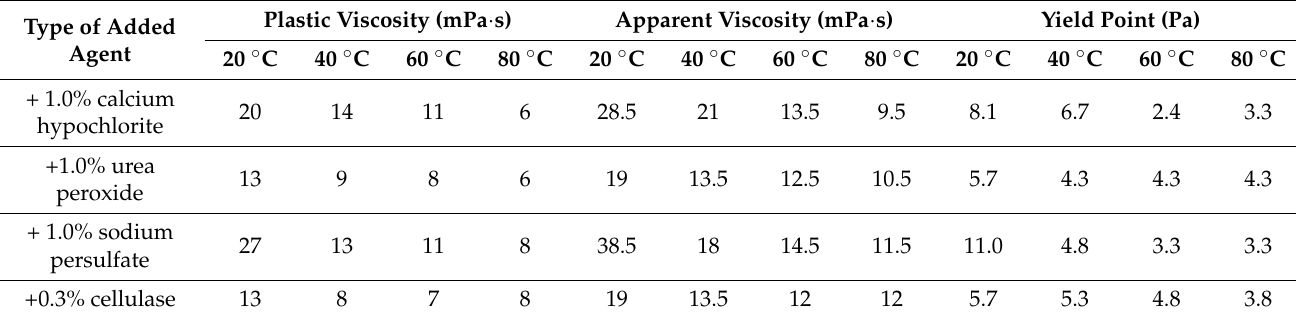
Table 4. The rheological parameters of potassium-polymer drilling mud B with thinning additives at various tempera- ture values.